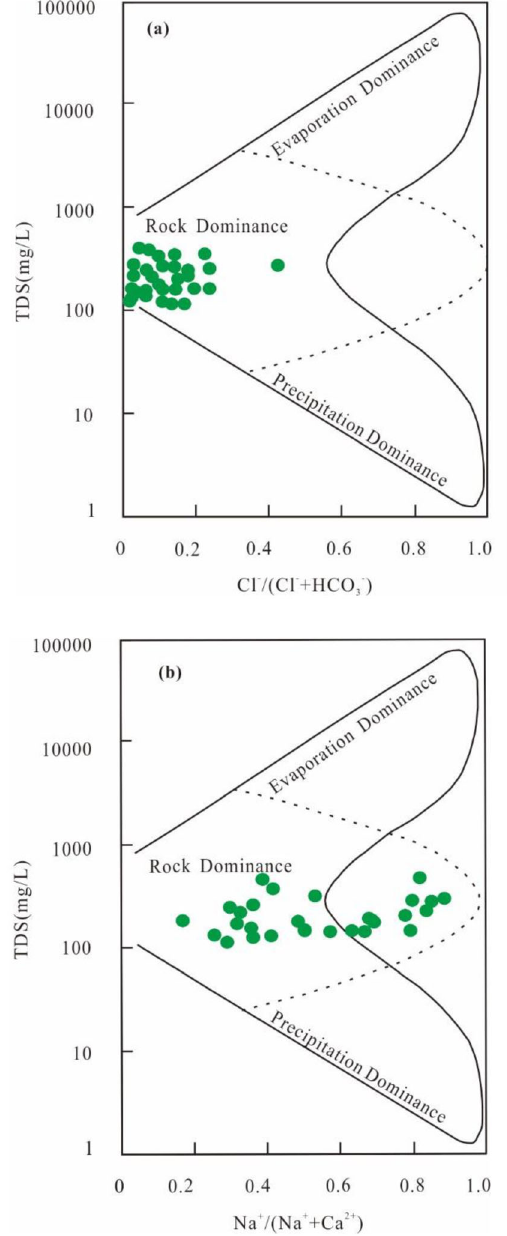
Fig. 4 Gibbs diagrams indicating the natural evolution mechanisms of groundwater Table 3, the SAR values range from 0.45 to 6.28, with an average of 2.01.